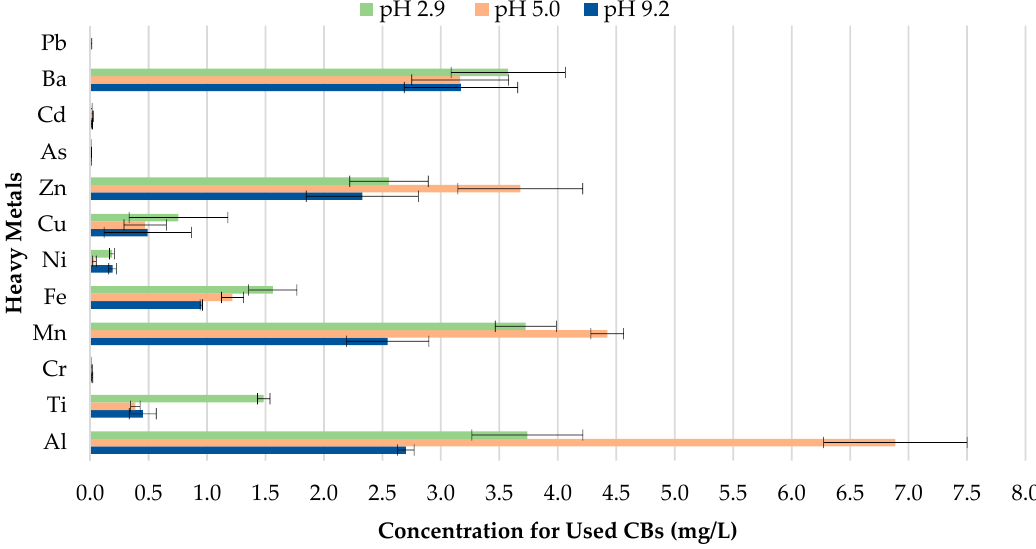
Figure 8. Leachate concentrations of used CBs.